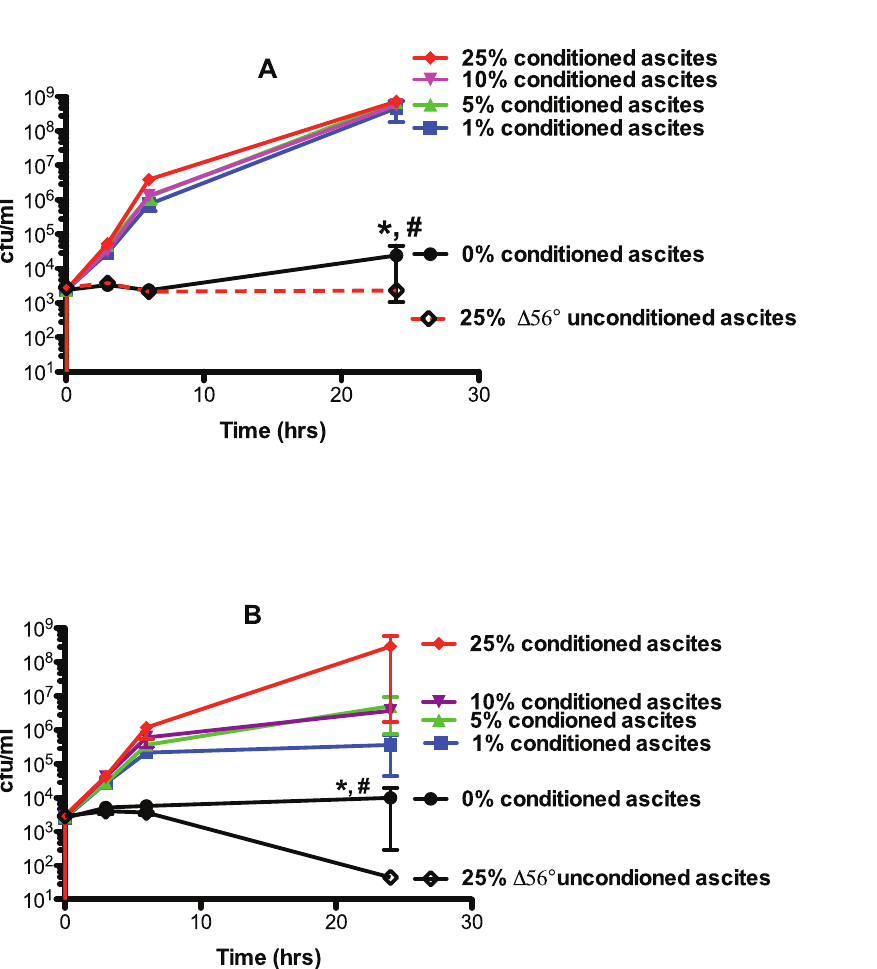
Figure 2. Growth and/or survival of hvKP1 grown in human ascites supplemented with varying concentration of homologous, conditioned ascites. The growth and/or survival of hvKP1 was assessed at 0, 3, 6, and 24 hours in 100% human ascites supplemented with homologous conditioned ascites resulting in final concentrations of 0%, 1%, 5%, 10%, and 25%. Growth and/or survival was also assessed in ascites supplemented with 25% unconditioned ascites heated at 56 u C for 30 minutes to control for a possible effect of conditioned ascites diluting complement-mediated bactericidal activity. Panel A: ascites batch 1. Panel B: ascites batch 2. Supplementation with 5%, 10%, and 25% conditioned, homologous ascites, compared to 0%, resulted in a significant increase in growth and/or survival for both batches of ascites (* P , 0.05/4) and supplementation with 1% conditioned, homologous ascites resulted in a trend for increased growth and/or survival ( # P . 0.05/4 and , 0.05). Data are Mean 6 S.E.M.; N=2–3.